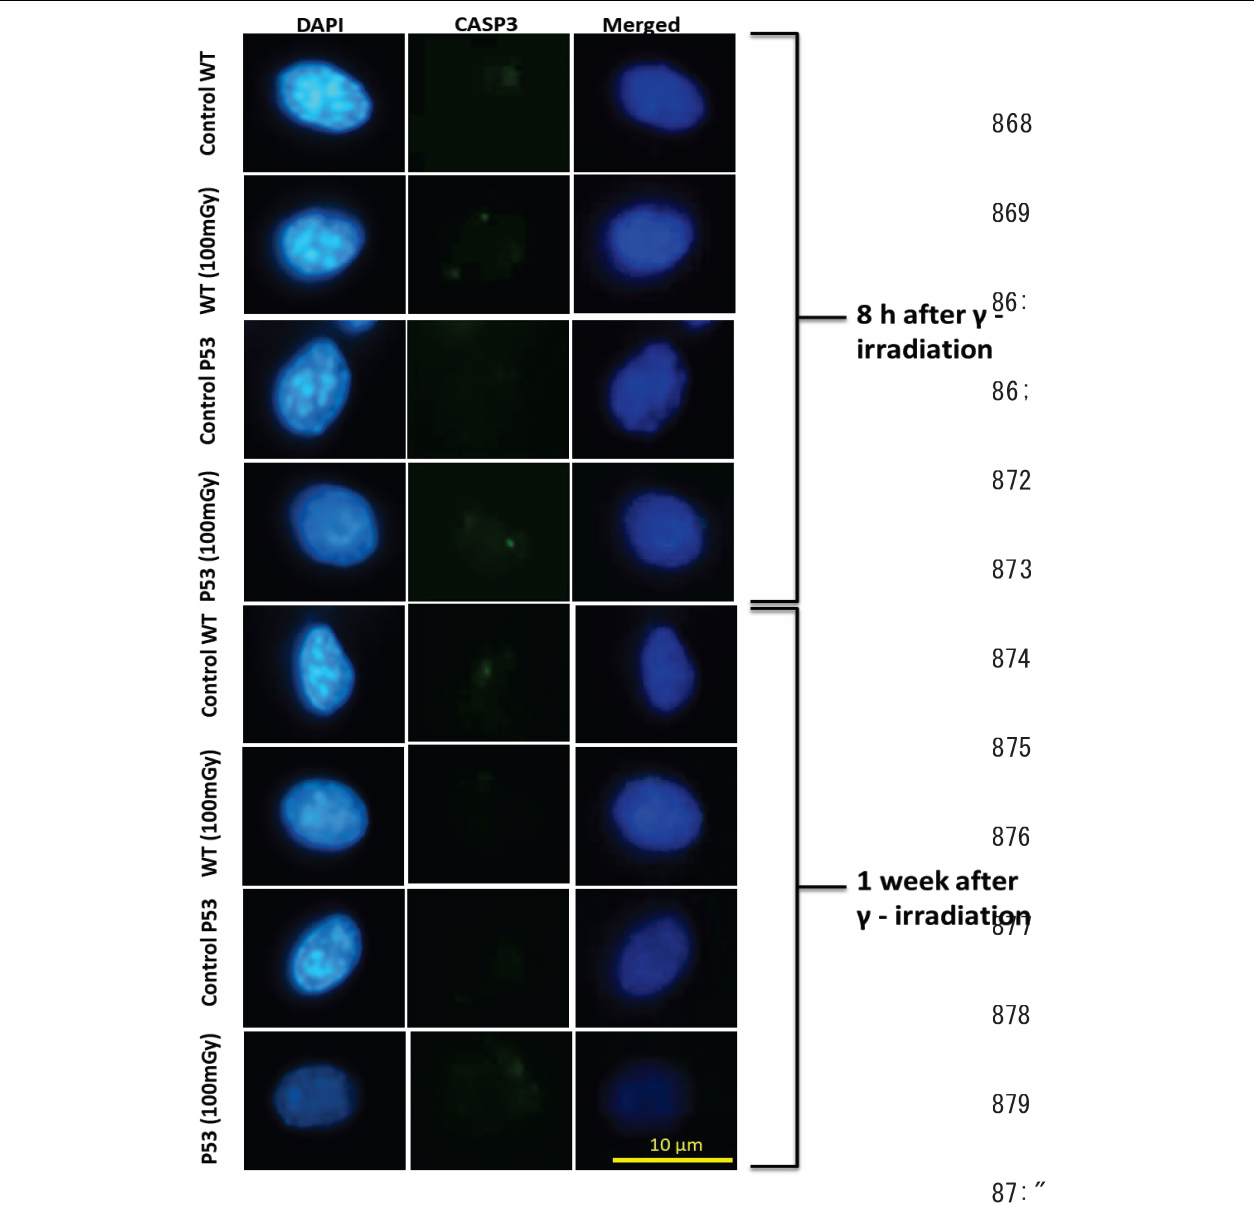
FIGURE 2 | Foci of cleaved caspase 3 (CASP3) in the erythrocytes of the irradiated medaka ( O. latipes ). Left/center/right column shows DAPI-stained (blue), anti-cleaved CASP3 immunostained (green), and merged images of nuclei of the erythrocytes 8 h and 7 days after the end of the irradiation, respectively. Scale bar represents 10 µ